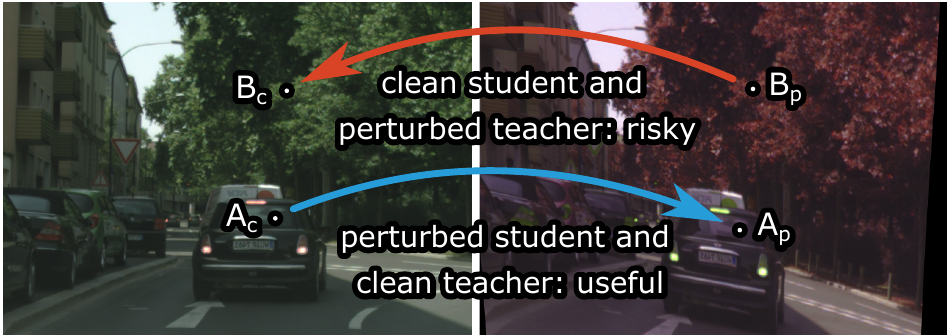
Figure 3. Two variants of one-way consistency training on a clean image ( left ) and its perturbed version ( right ). The arrows designate information flow from the teacher to the student. The proposed clean-teacher formulation trains in the perturbed pixels (A p ) according to the corresponding predic- tions in the clean image (A c ). The reverse formulation (training in B c according to the prediction in B p ) worsens performance, since strongly perturbed images often give rise to less accurate